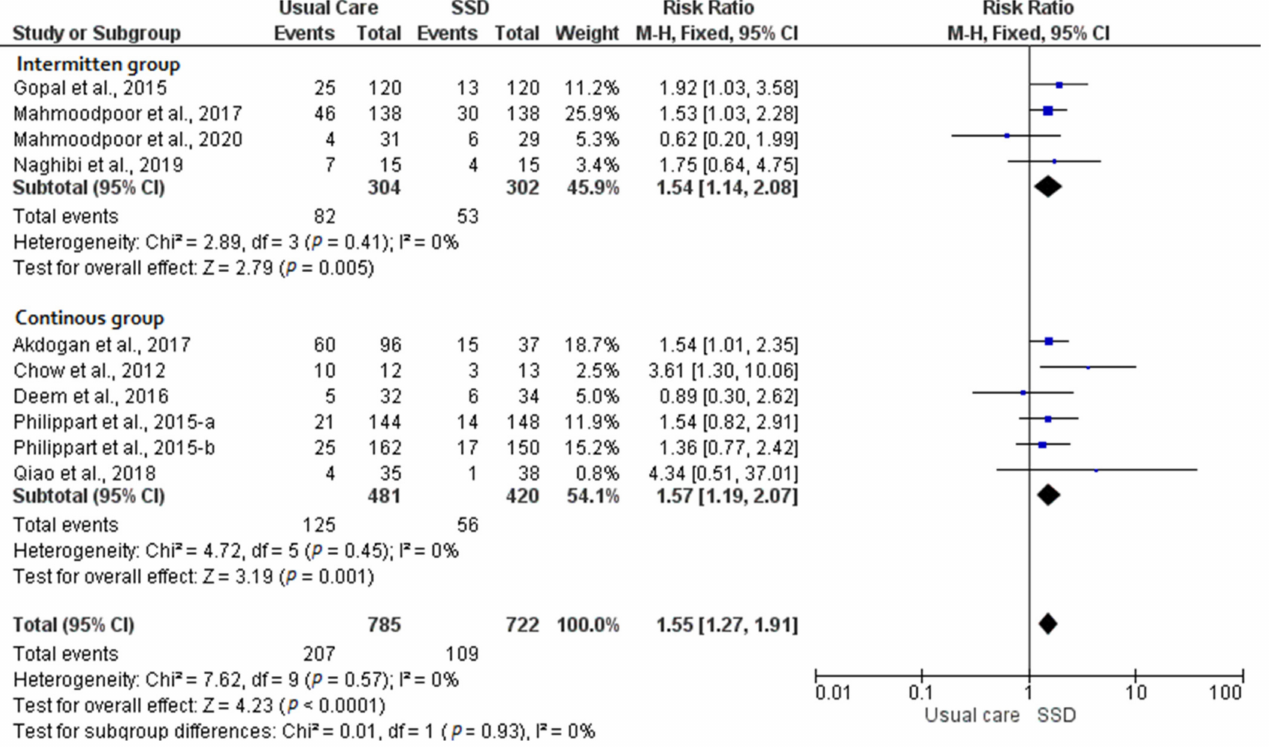
Figure 3. Subgroup analysis of VAP risk outcome between the usual care group and the SSD group